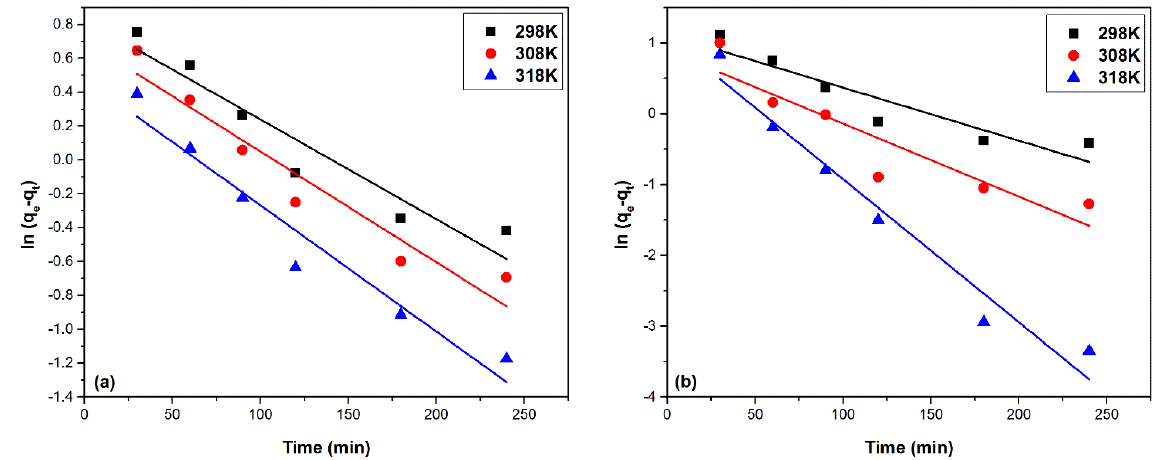
Figure 9. Pseudo-first-order kinetic models: ( a ) MgSiO 3 -DB18C6, ( b ) MgSiO 3 -DB30C10.